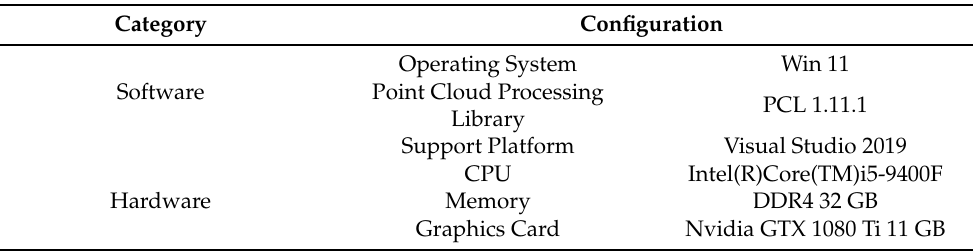
Table 2. Platform configuration. A suitable test platform is selected whose software and hardware meet the requirements of the